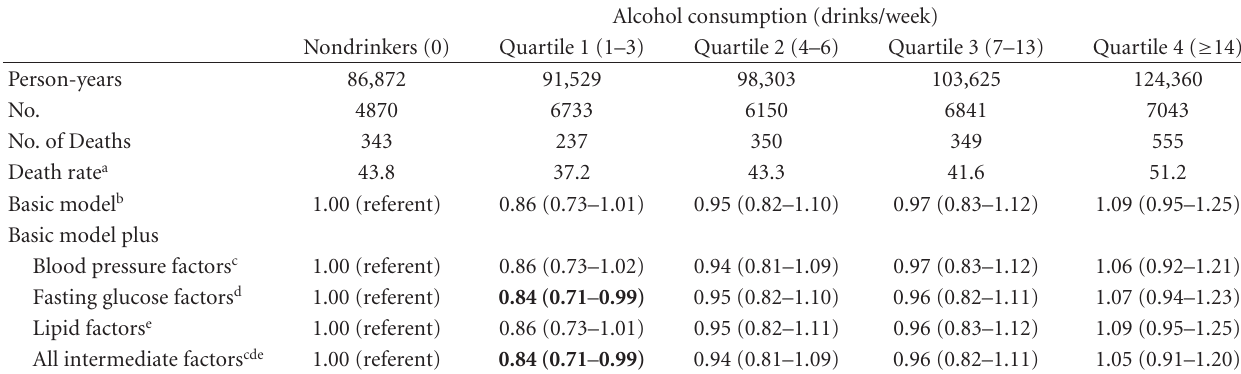
Table 2: Hazard ratios of all-cause mortality by alcohol consumption level in men, Aerobics Center for Longitudinal Study (ACLS), 1974–